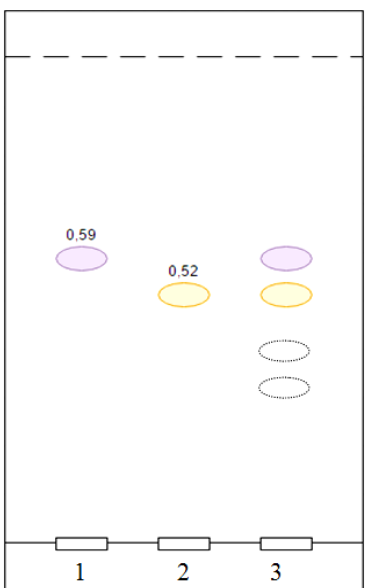
Fig. 1. Scheme of chromatography of the inulin hydroly- zate complex obtained from dahlia’s tubers of the “Ken's Flame” species: 1 – solution of fosfaturic acid fructose (1·10 -5 μg); 2 – solution of glucose FSH (2,5·10 -5 μg);